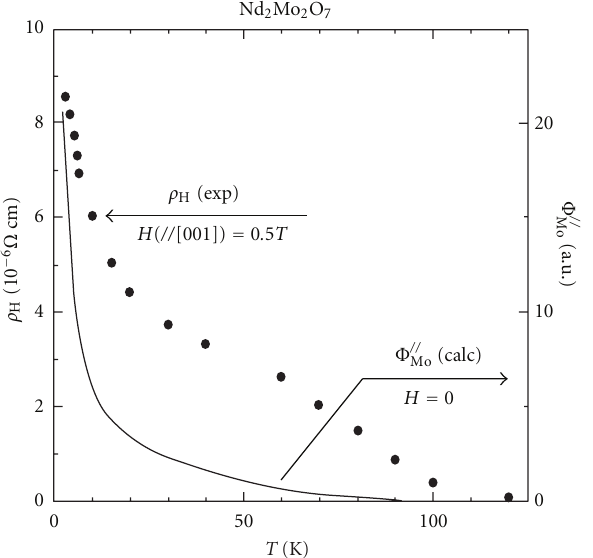
Figure 6: A plot of experimental Hall resistivity, ρ H , in Nd 2 Mo 2 O 7 as a function of temperature. The mismatch between the experimental values and the fictitious magnetic flux, Φ Mo , calculated from the chirality of the magnetic structure indicates that the chirality mechanism is not the majority component of the AHE. The figure is taken from